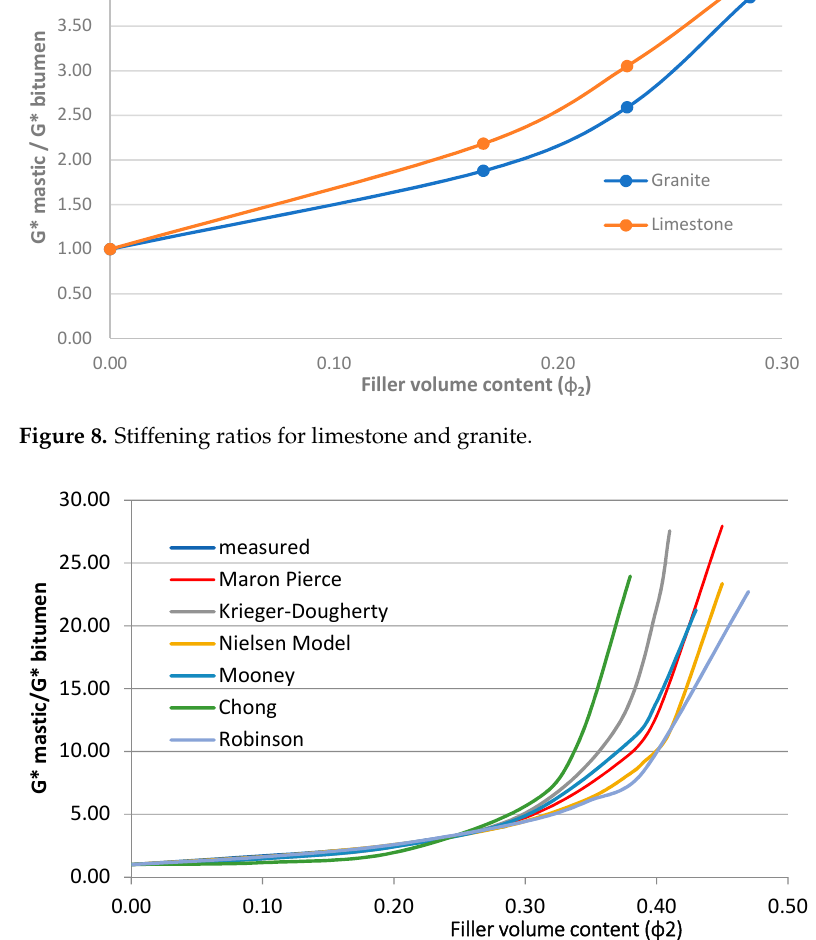
Figure 9. Micromechanics models for limestone mastic.